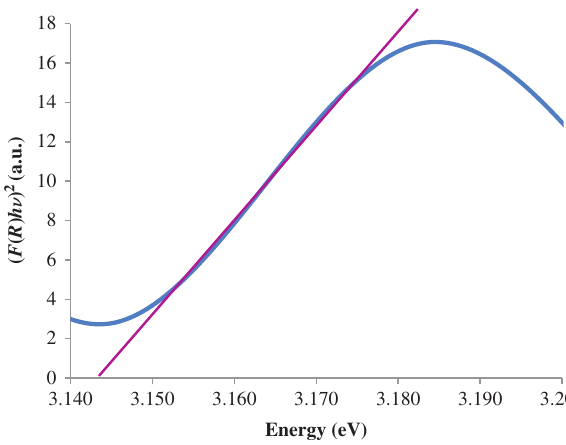
Figure 4: Kubelka – Munk model for calculation of FeAl 2 O 4 nano- powders band gap.